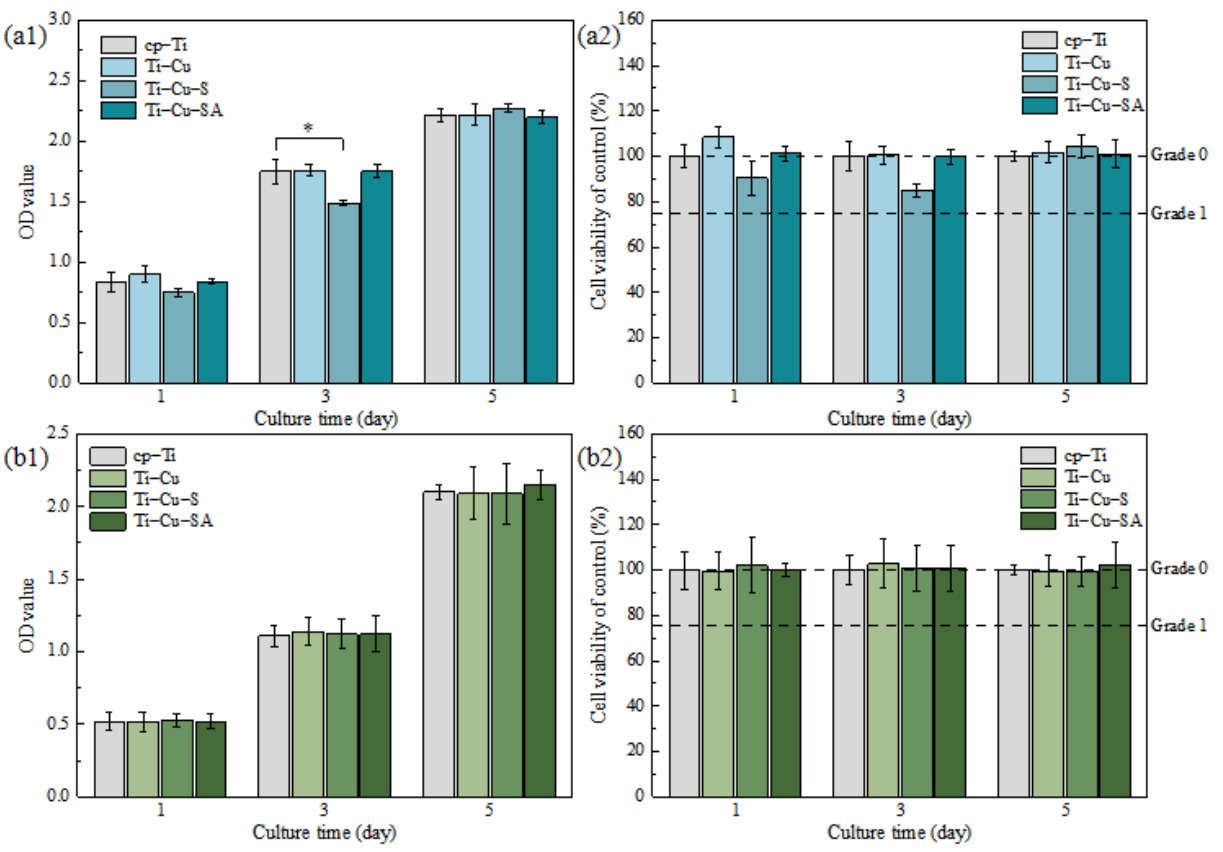
Figure 7. Cell toxicity of samples against MC3T3-E1 (* p < 0.05) ( a1 ) OD values of alloys determined by direct contact method; ( a2 ) OD values of alloys determined by extract toxicity; ( b1 ) Cell viability of alloys determined by direct contact method; ( b2 ) Cell viability of alloys determined by extract toxicity.